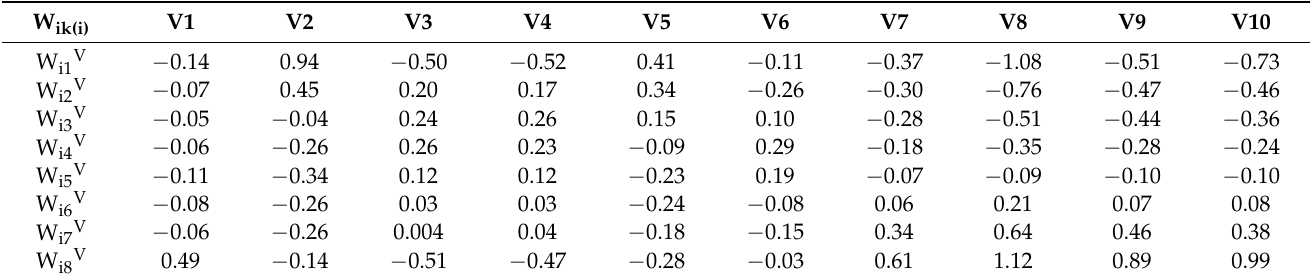
Table 5. Weights assigned to the independent variables in the statistical analyses carried out at Vaglio Basilicata.